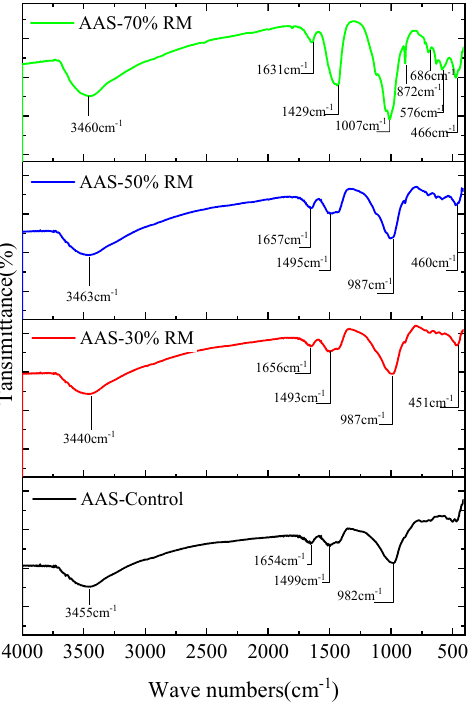
Figure 8. FTIR spectra of the AASR with different additions of RM.